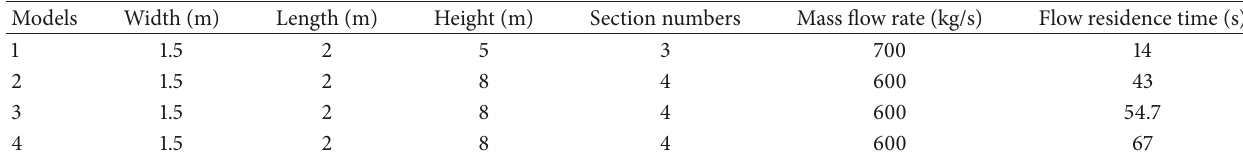
Table 2: Decay tank models and CFD